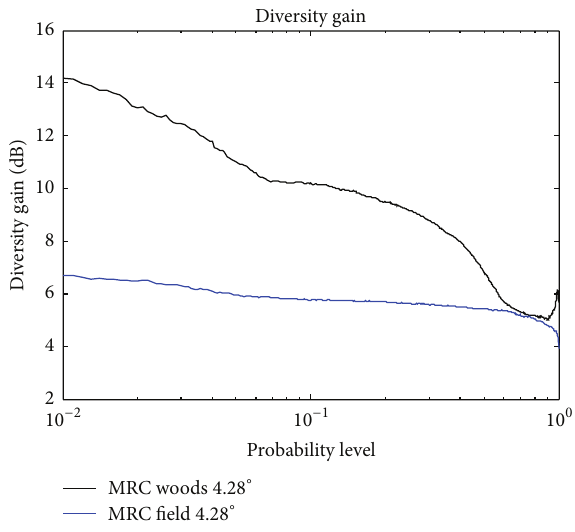
Figure 5: Measured and uncorrelated Rayleigh model 4-branch incremental diversity gains with MRC.